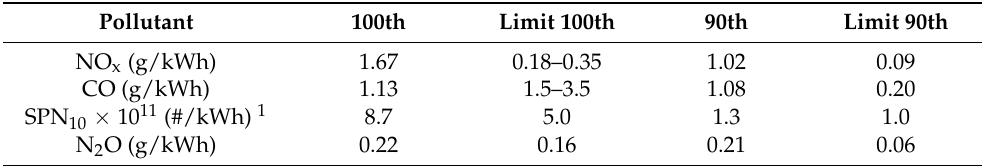
Table 4. Emission factors of the real-world cycle (RWC) and the respective limits ranges that have been suggested for the future regulation [50]. Note that on-road testing will not include any confor- mity